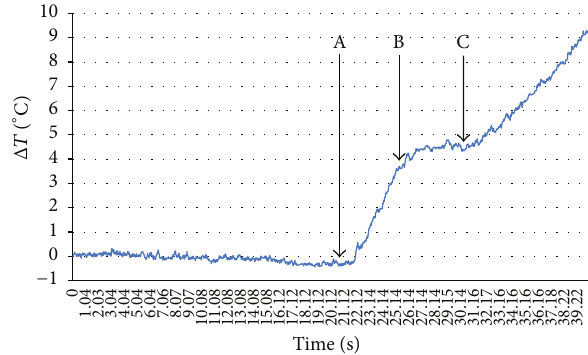
Figure 3: Changes of maximum temperature during the elastic and at the beginning of plastic deformation.